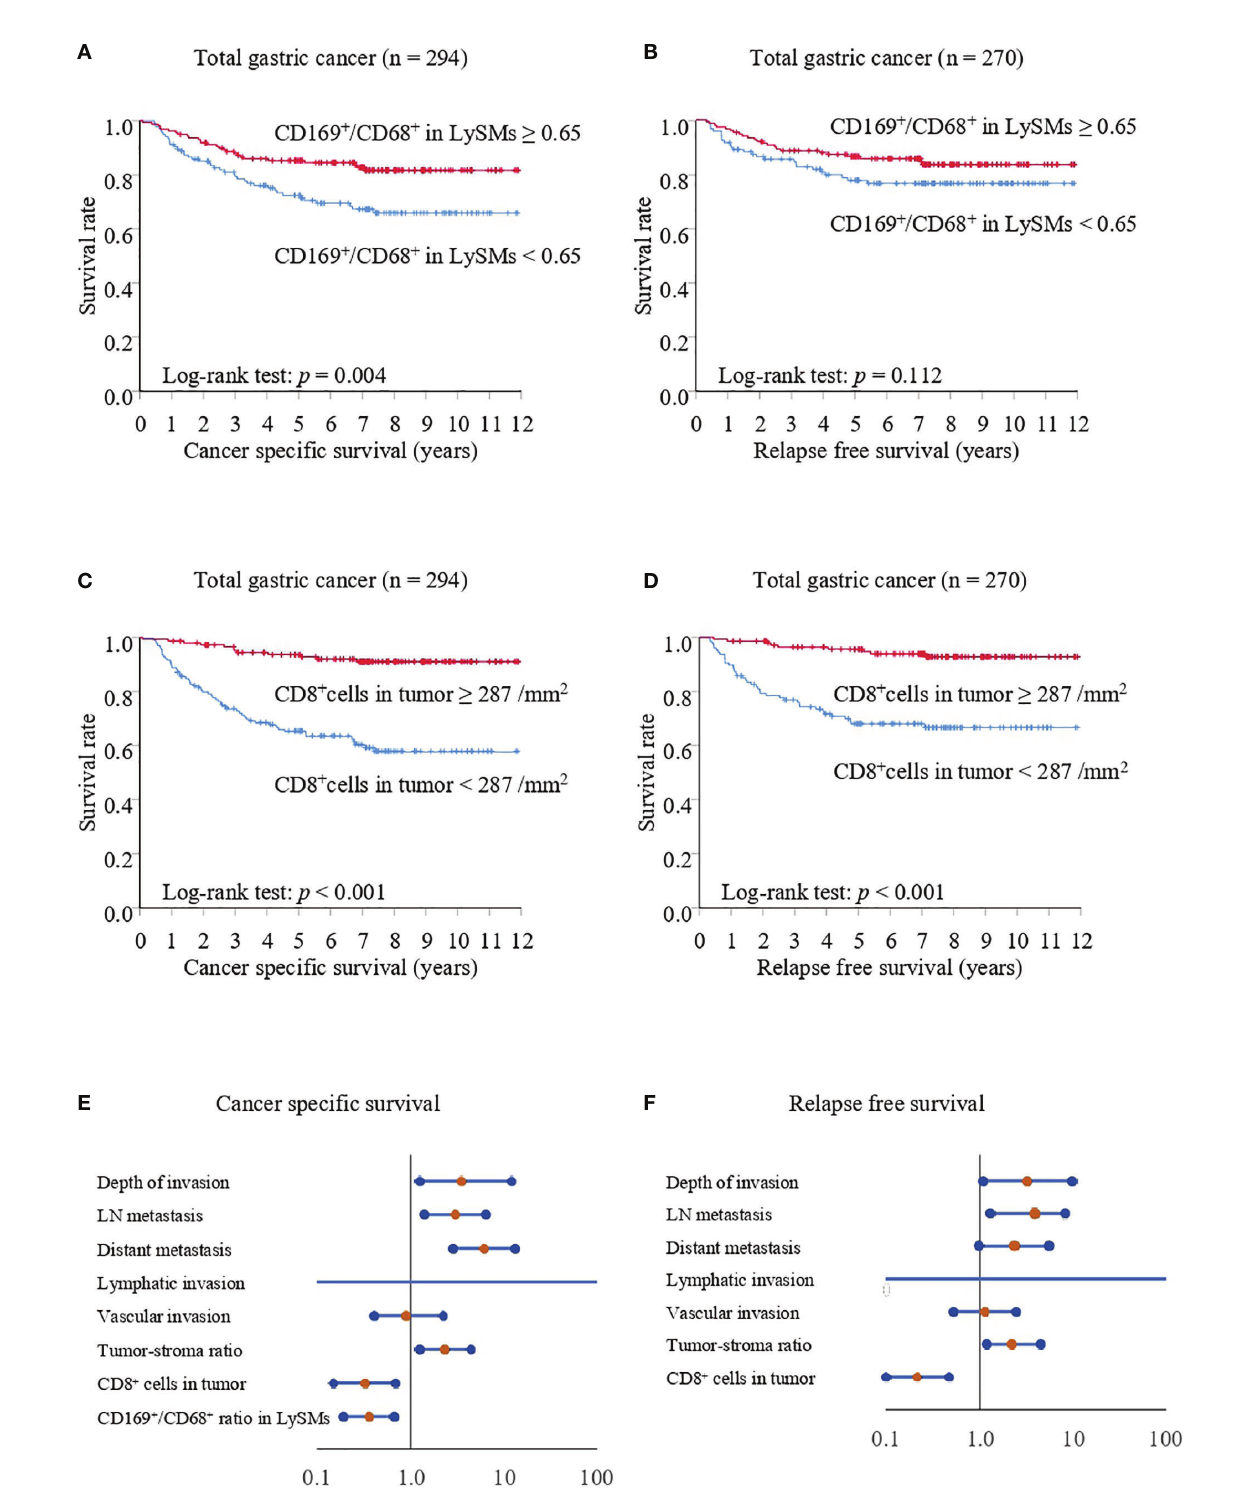
FIGURE 3 | Kaplan-Meier cancer-speci fi c survival and relapse-free survival curves for total gastric cancer cases. The patients were divided into two groups according to their CD169/CD68 ratio: < 0.65 was de fi ned as low and ≥ 0.65 was de fi ned as high (A, B) or divided into two groups according to their density of CD8 + cells: < 287/mm 2 was de fi ned as low and ≥ 287/mm 2 was de fi ned as high (C, D) . (A, C) Cancer-speci fi c survival (CSS) curves for patients with total gastric cancer. (B, D) Relapse-free survival (RFS) curves for patients with total gastric cancer. (E) Forest plot analysis of CSS. (F) Forest plot analysis of